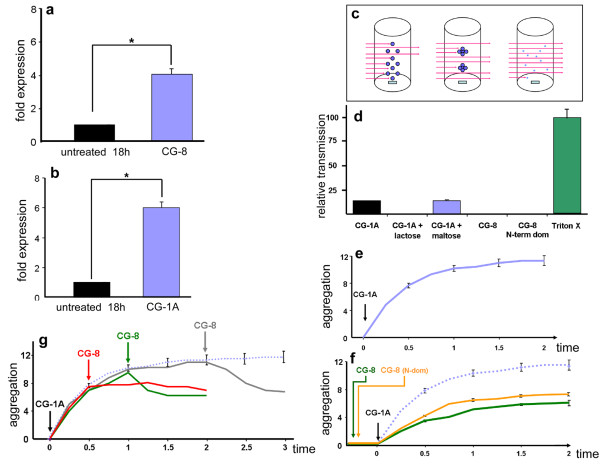
Multiscale interactions of CG-1A and CG-8. (a) CG-1A gene expression assayed by qRT-PCR in 18 h cultures treated with 10 μg/ml CG-8 (blue bar) was 4-fold that of untreated controls (black bar). (b) CG-8 gene expression in 18 h cultures treated with 10 μg/ml CG-1A (blue bar) was 6-fold that of untreated controls (black bar). Difference between relative mean mRNA values was statistically analyzed by Student's t-test. Results are shown as mean ± S.E.M. (* p < 0.05). (c) Scheme of the principle of optical aggregometry (turbidimetry). (d) Graph comparing the aggregation of 5-day leg bud autopod cells induced by addition of CG-1A, CG-1A pre-incubated with lactose or maltose (osmolarity control), and CG-8 as well as its N-terminal domain. Lysing cells with Triton X-100 (green bar) provides a baseline for maximal light transmission under the conditions of the assay. The maximum possible transmission achieved by Triton X-100 treatment is considered 100%. Results are shown as mean ± S.E.M. (e) Plot showing the cell aggregation in real time induced by CG-1A. (f) Plot showing real-time cell aggregation induced by CG-1A in cells preincubated with either CG-8 (green) or its N-terminal domain (orange). Control aggregation (dotted blue line) occurred in cells not pre-treated with CG-8. The aggregation values in assays with the N-terminal domain of CG-8 represent the mean of two independent experiments. (g) Plot showing real-time change in cell aggregation when CG-1A was added first (to initiate the aggregation) and then CG-8 was added at different time-points (red: CG-8 added at 0.5 s, green: CG-8 added at 1 s; blue: CG-8 added at 2 s). The ordinate axis units shown in e, r and g are arbitrary units and are comparable. Values for e, f and g are mean ± S.E.M.